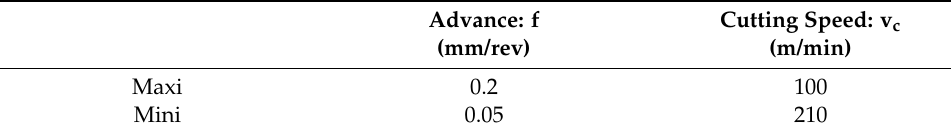
Table 3. Cutting parameters used in experimental